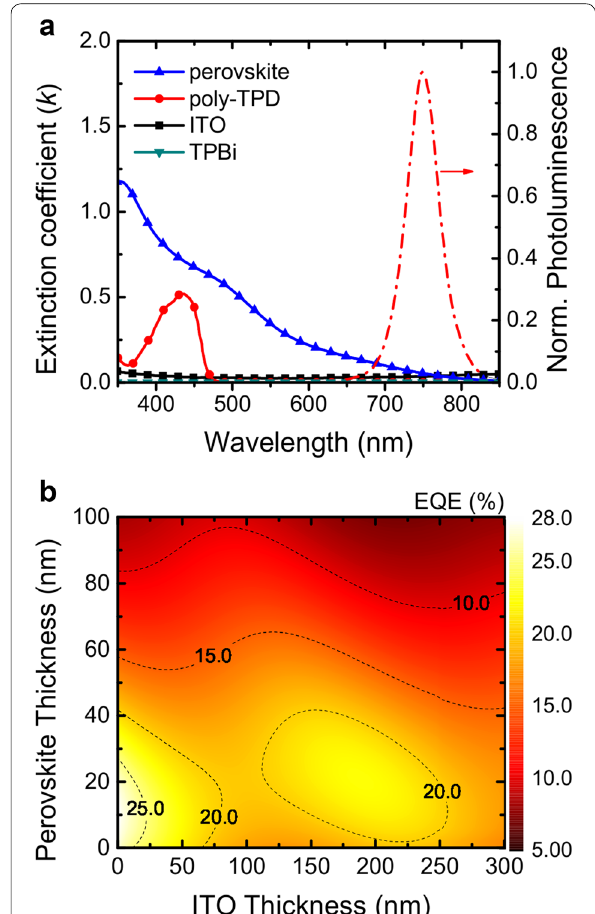
Fig. 2 a Spectra of the extinction coefficients of perovskite, poly‑TPD, ITO, and TPBi. The normalized photoluminescence spectrum of the perovskite layer is also included. b Contour plot of the maximum achievable EQE of the PeLED as a function of ITO and perovskite